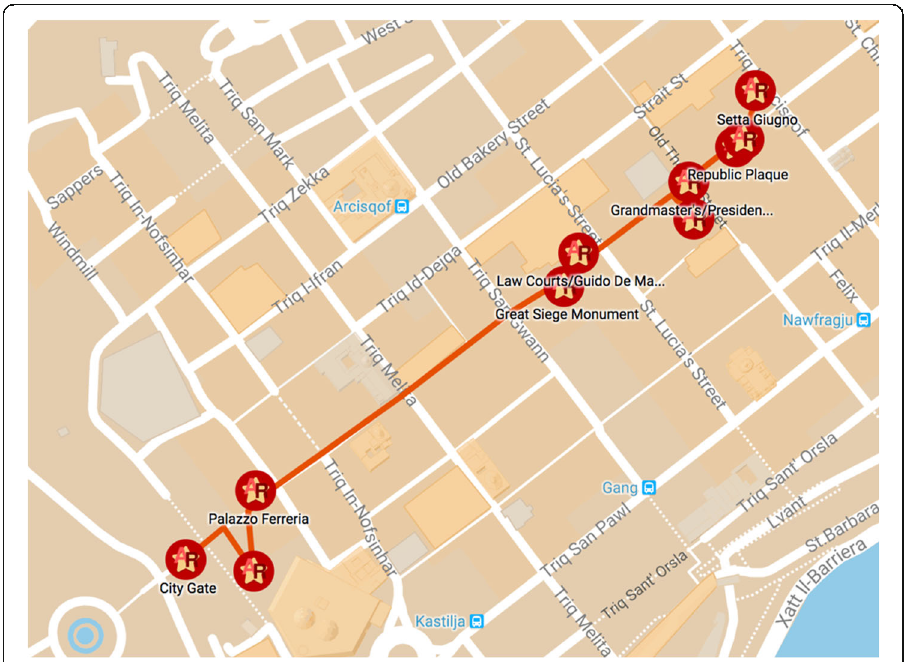
Fig. 2 The Maltese Democracy Smart Learning Journey route in Google Maps